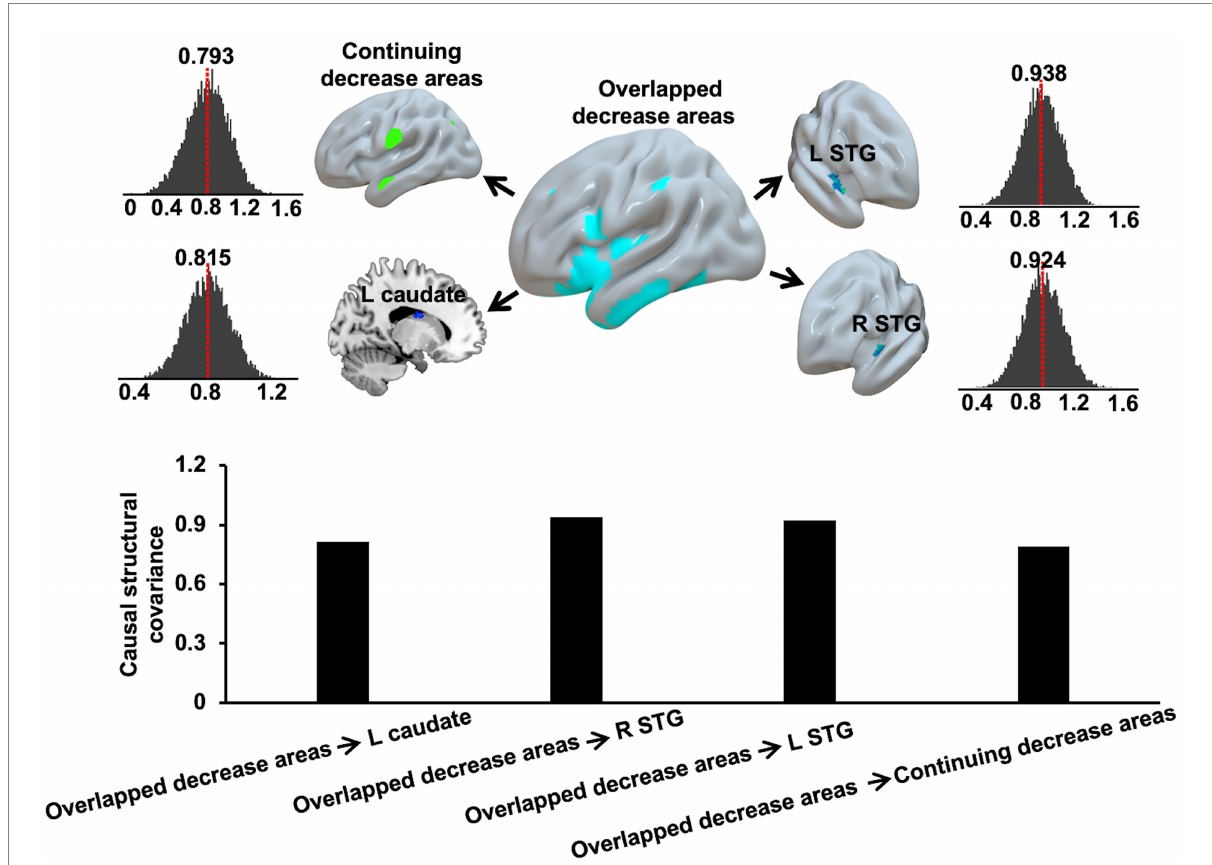
FIGURE 6 Causal effects of overlapped decrease areas in AD-T1 on the continuing decrease areas, left and right STG, and left caudate in AD-T2. The red dash lines and the bar plots indicate the mean causal correlation between GMV of the overlapped decrease areas and GMV of continuing decrease areas, left and right STG, and left caudate in AD-T2 across 10,000 permutations.